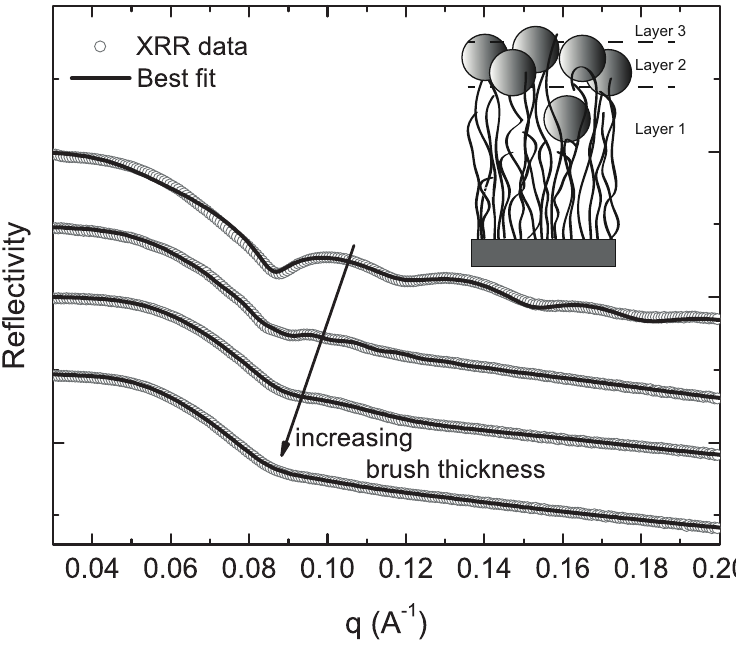
Layer 3 1Layer 2 Layer Si